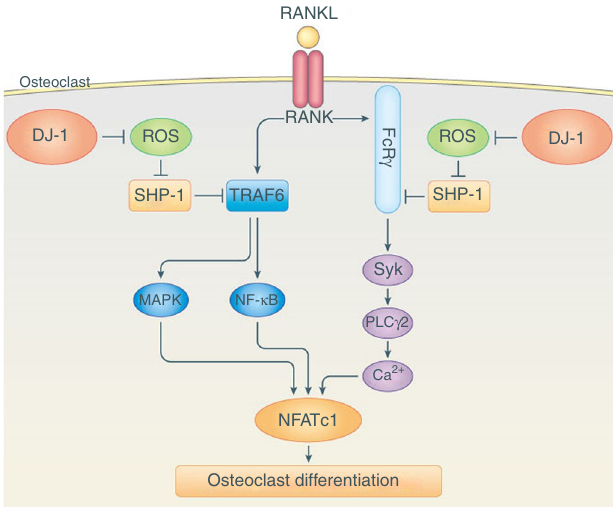
Fig. 8 A proposed scheme for DJ-1 regulation of osteoclastogenesis. The binding of RANKL to RANK activates both TRAF6- and co-stimulatory ITAM-mediated signaling pathways. Both pathways are essential for full ampli fi cation of NFATc1 and as a consequence osteoclastogenesis. The activation of RANK also results in production of ROS which inhibits